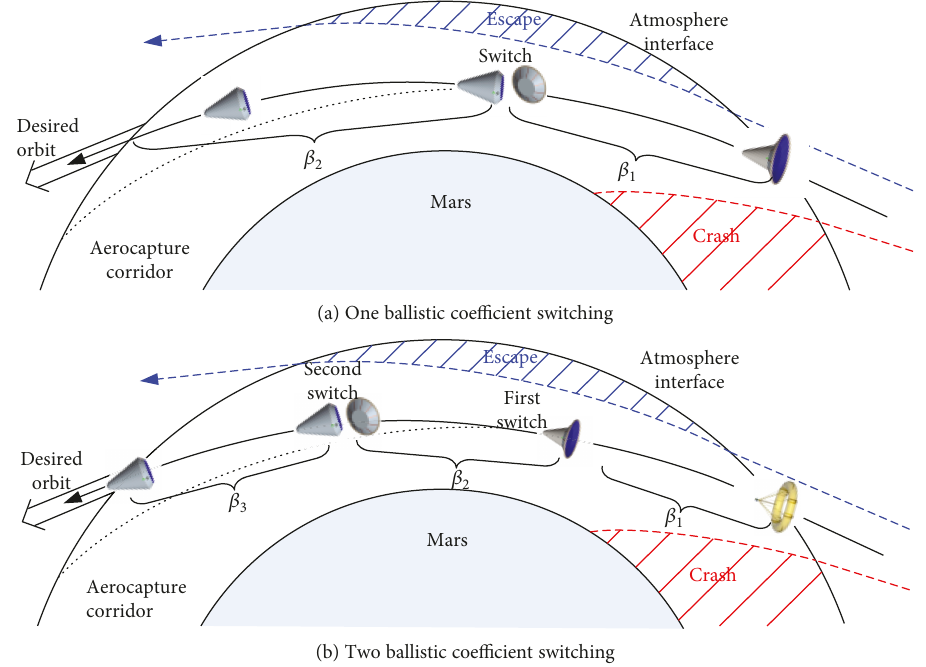
Figure 1: Aerocapture concept based on the piecewise variable ballistic coe ffi